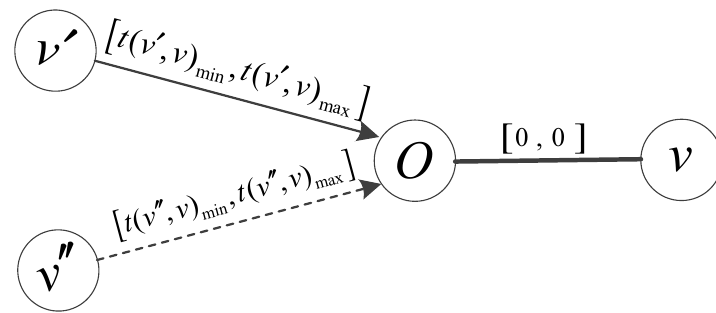
Figure 3. Transformation of the OR discrepancy node.